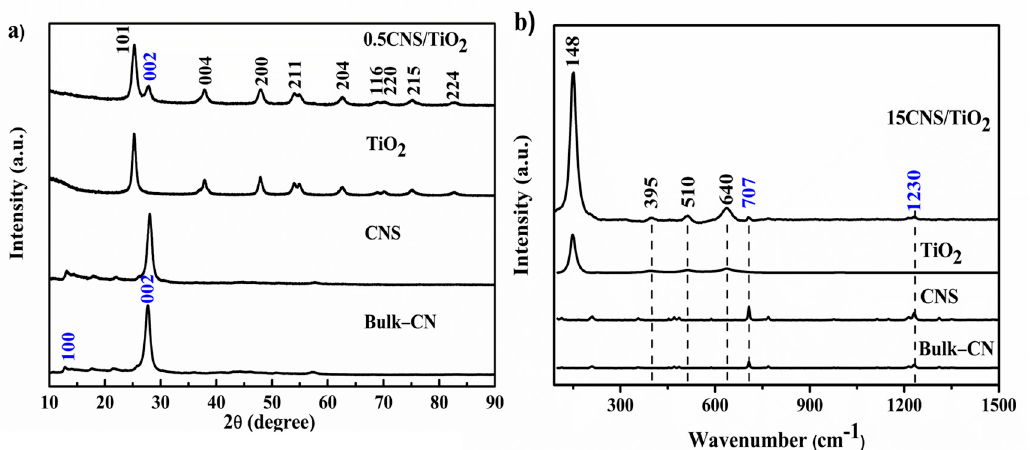
Figure 1. ( a ) Powder XRD patterns of bulk-CN, CNS, TiO 2 , and 0.5CNS/TiO 2 . ( b ) Raman spectra of bulk-CN, CNS, TiO 2 , and 15CNS/TiO 2 . Figure S1 shows the PXRD of the rest of nanocomposites.